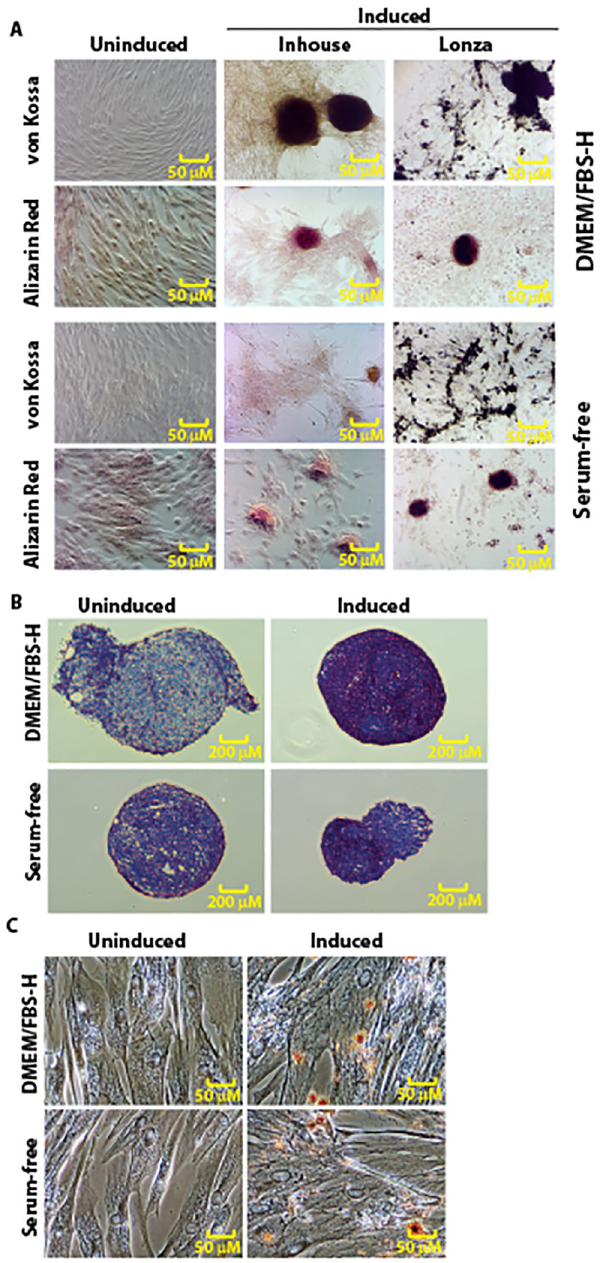
Fig 9. Trilineage differentiation of canine Ad-MSCs expanded in DMEM/FBS-H or serum-free medium containing bFGF and PDGF. A . Osteogenic potential of canine Ad-MSCs cultured in DMEM/FBS-H or serum-free medium containing bFGF and PDGF was assessed with Alizarin Red or von Kossa staining after 14 days of induction. Canine Ad-MSCs cultured in both media types formed calcified cell aggregates. B . Chondrogenic potential of canine Ad-MSCs cultured in DMEM/FBS-H or serum-free medium containing bFGF and PDGF was assessed with Toluidine Blue staining after 14 days of induction. C . Adipogenic potential of canine Ad-MSCs cultured in DMEM/FBS-H or serum-free medium containing bFGF and PDGF was assessed with Oil Red O staining after 14 days of induction/ maintenance. Uninduced cells maintained their characteristic spindle shaped morphology. Upon induction, canine Ad-MSCs cultured in both media types formed adipocytes with intracellular lipid droplets.